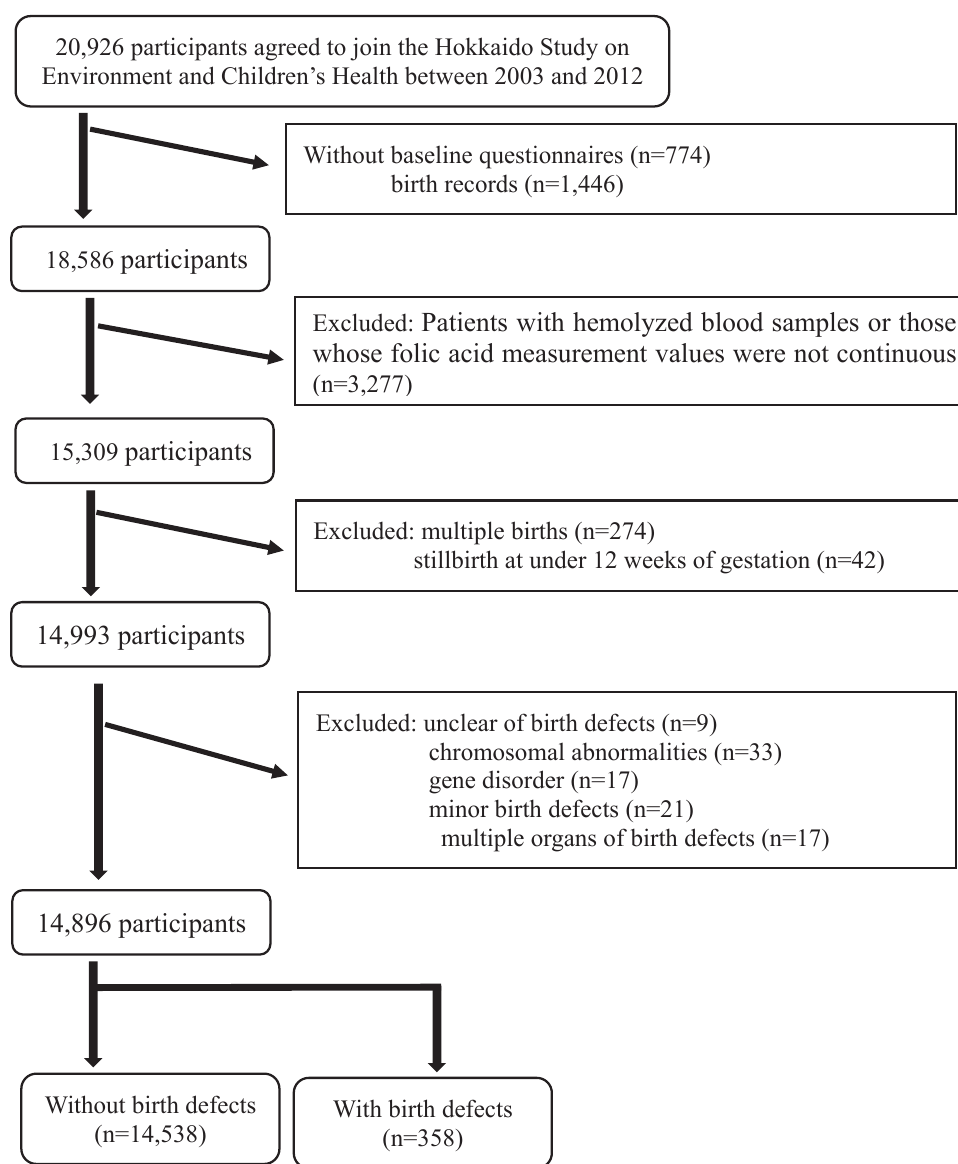
Figure 1. Flowchart of inclusion and exclusion criteria for the study